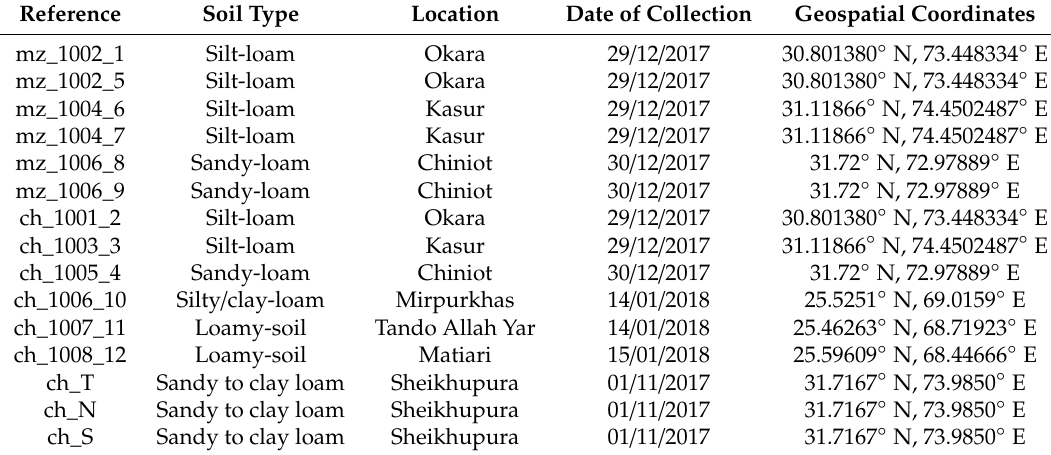
Table 1. Soil samples collected for the baseline study (with, respectively, reference number: ‘mz’ prefix = maize growing, ‘ch’ prefix = chili growing soil, soil type [38], location (nearest town), date of collection, and geospatial